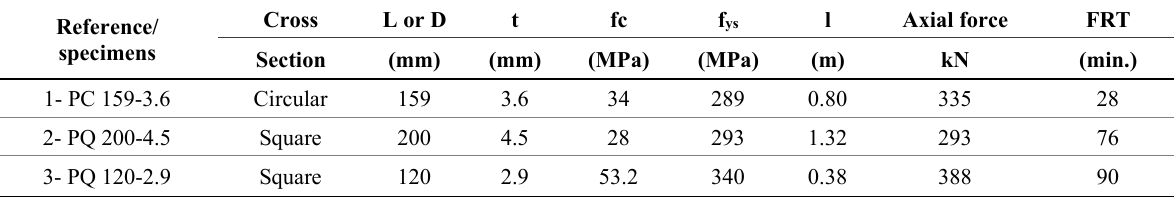
Table 3. Characteristics of specimens and experimental results.